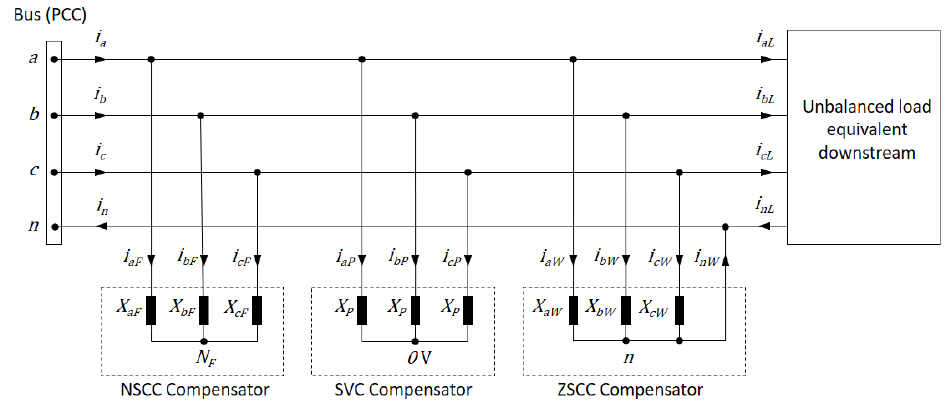
Figure 2. Proposal for compensation of an unbalanced three-phase four-wire linear system.